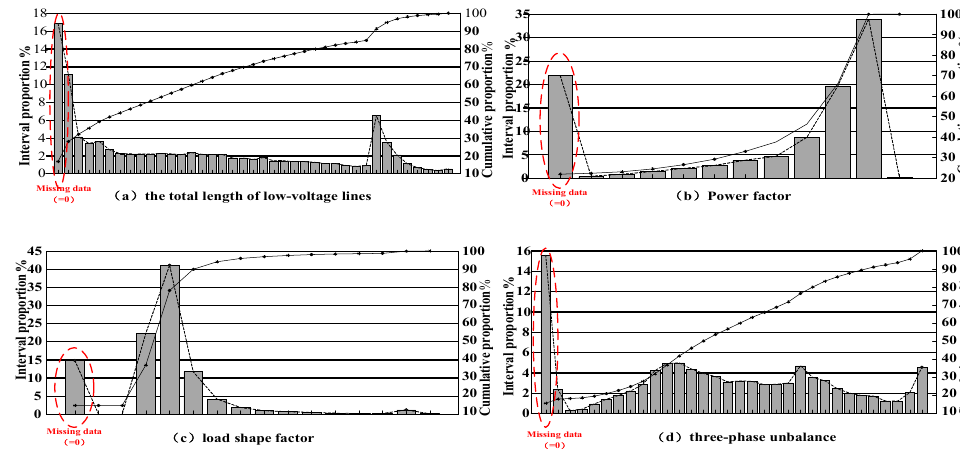
Figure 10. Distribution of characteristic factors.